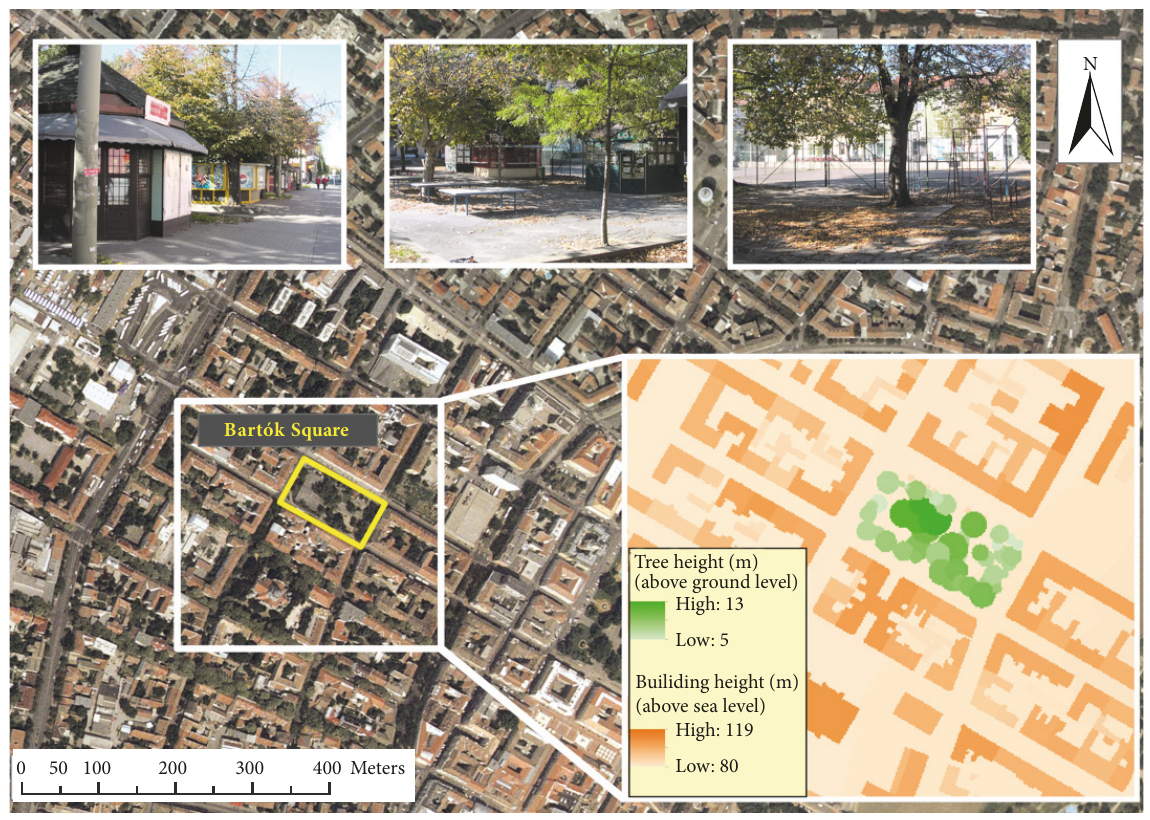
Figure 1: Bart´ok Square of Szeged, illustrated by an aerial image, site photos, and an object elevation